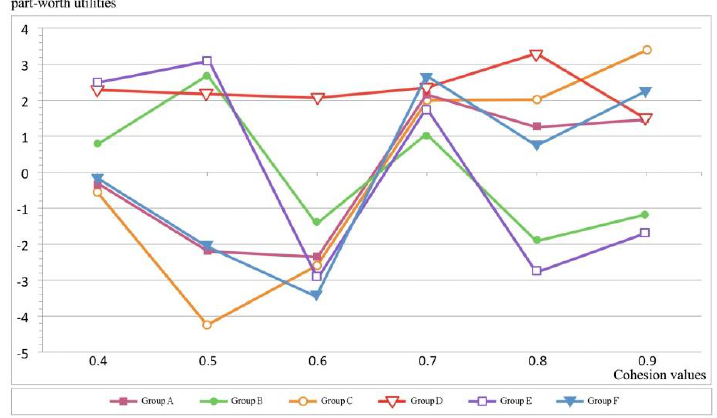
Figure 10. Part − worth utilities of different Cohesion values for the six